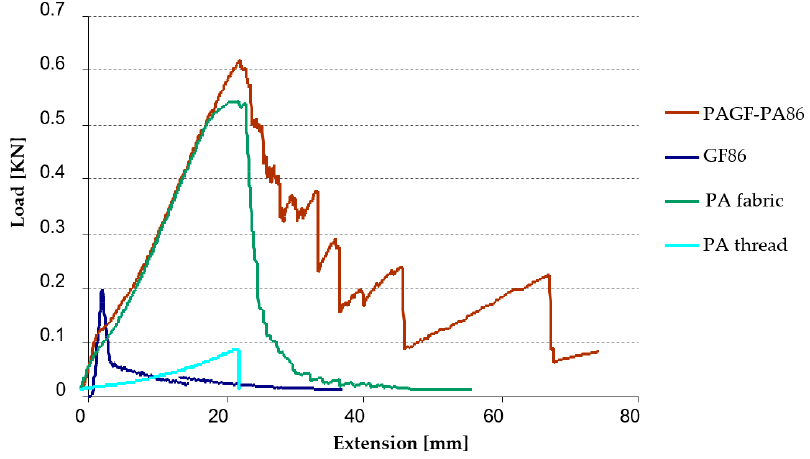
Figure 9. Tensile test curve of PA86 hybrid fabric compared with its